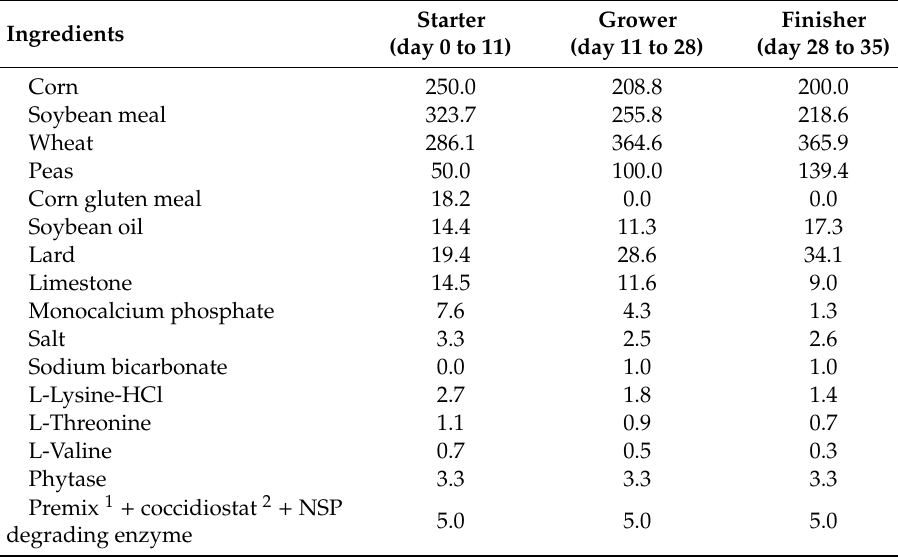
Table 1. Ingredient and nutrient composition (g / kg) of the basal